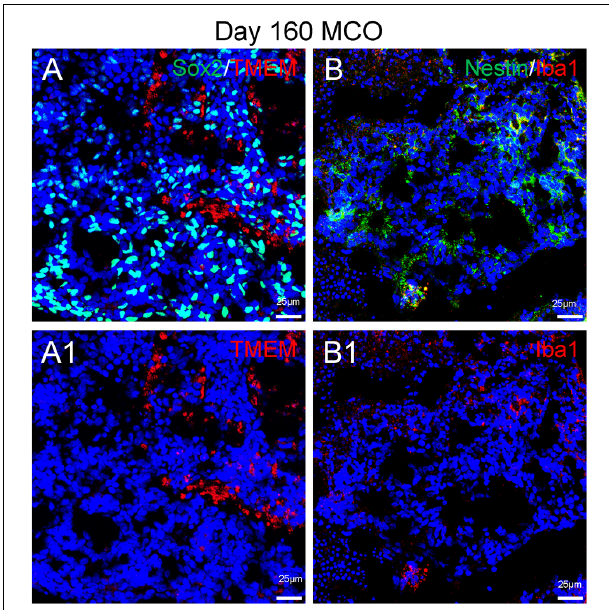
FIGURE 6 | Presence of microglia in Day 160 MCOs determined by microglia-specific marker TMEM119 (A) and IBa1 (B) . Neural stem/progenitor cells were labelled with anti-Sox2 (A) and anti-Nestin (B) antibodies. Hoechst was used as a nuclear marker. NC, necrotic center. Panels (A1) and (B1) are the split channels for corresponding (A) and (B) .